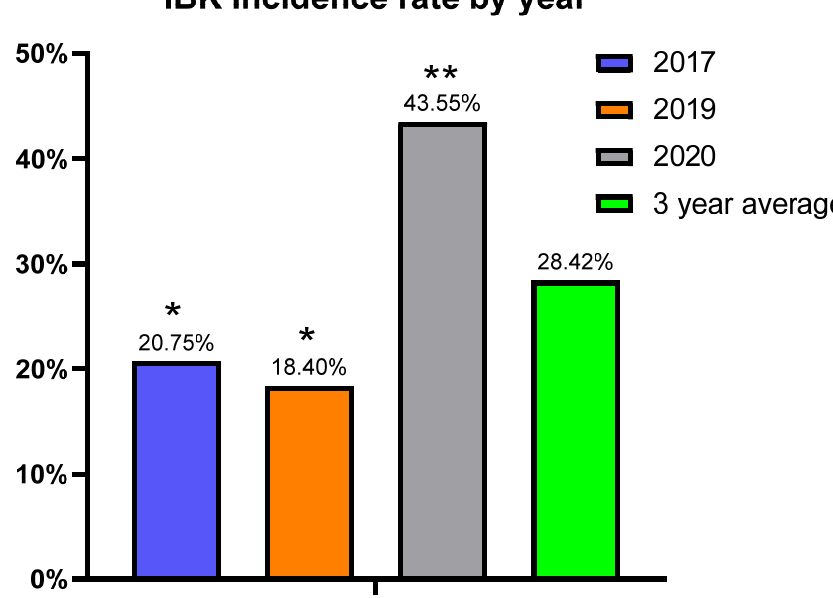
was 28.42% with 191 cases of IBK being diagnosed among the 672 calves. The yearly inci- IBK cases compared to either 2017 or 2019 (Figure 2). cases compared to either 2017 or 2019 (Figure 2).